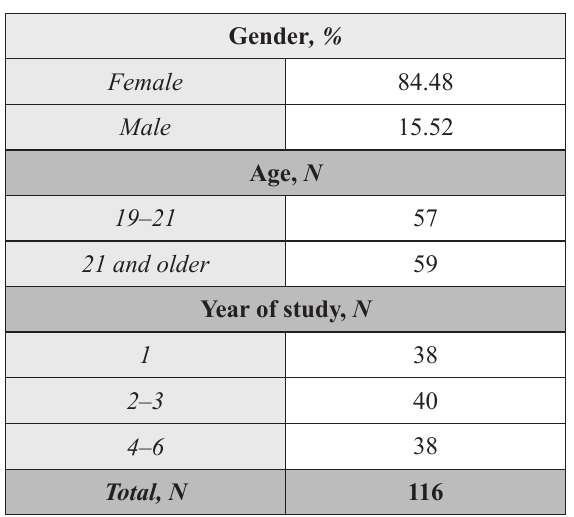
Figure 1. Sociodemographic